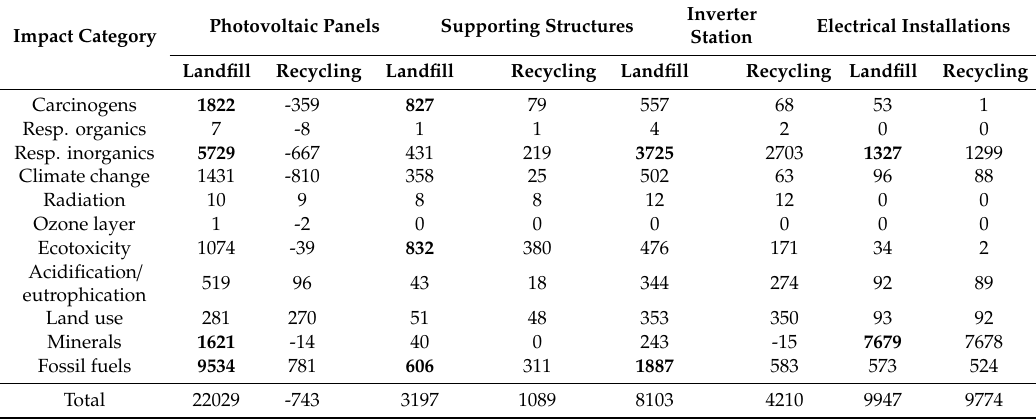
Table 3. Results of grouping and weighting environmental consequences, occurring in the cycle of existence of selected groups of 1 megawatt photovoltaic power plant [unit: Pt].